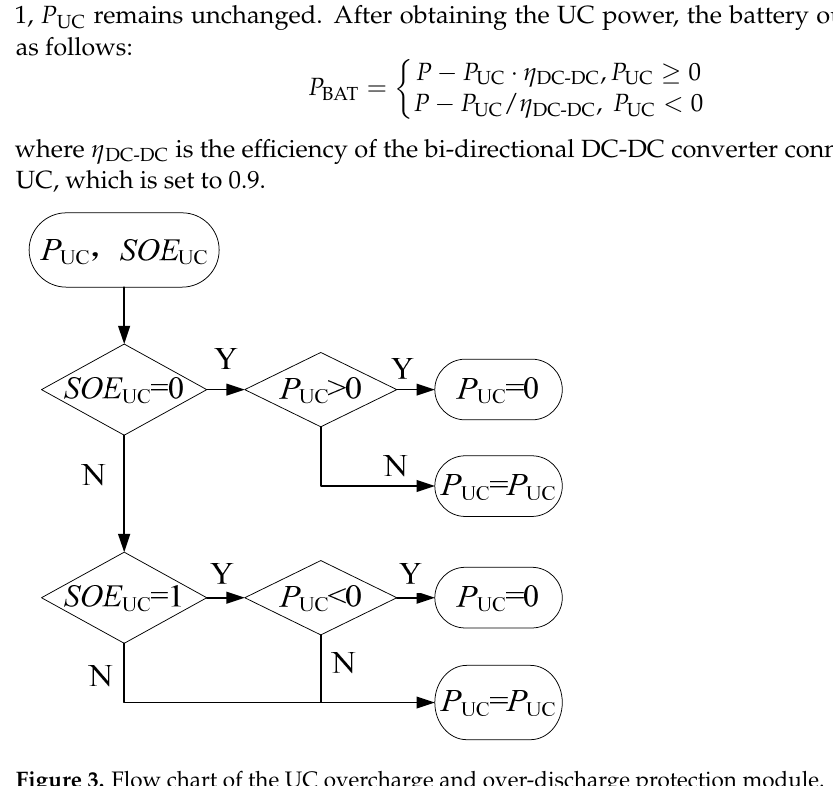
Figure 3. Flow chart of the UC overcharge and over-discharge protection module.